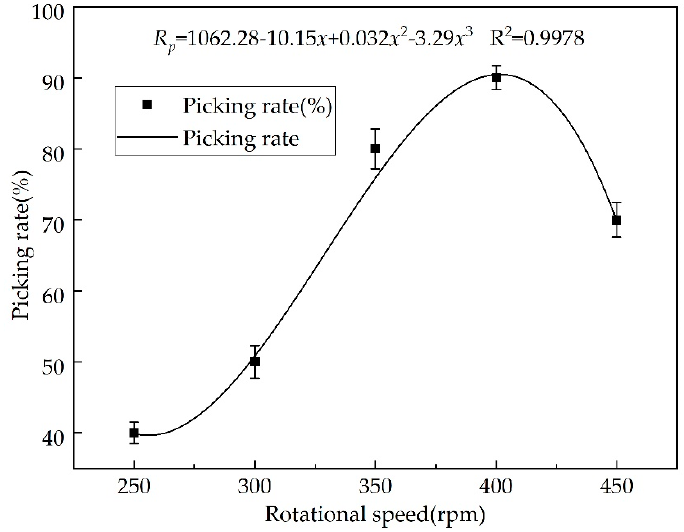
Figure 10. Results of the single-factor test of the clamping-picking device speed.